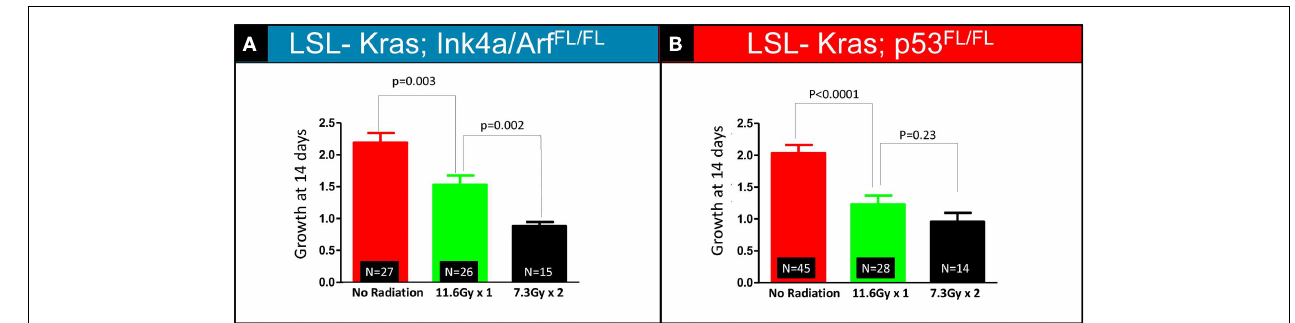
7.3Gy fractions separated by 24h compared to a single 11.6Gy treatment as measured by micro-CT at 14days after radiation treatment ( P = 0.002). (B) Lung cancers in LSL-Kras; p53 FL/FL mice respond to a single 11.6Gy fraction and two 7.3Gy fractions of radiation therapy with a small difference that is not statistically significant as measured by micro-CT at 14days after radiation treatment ( P = 0.23). Error bars – SEM.